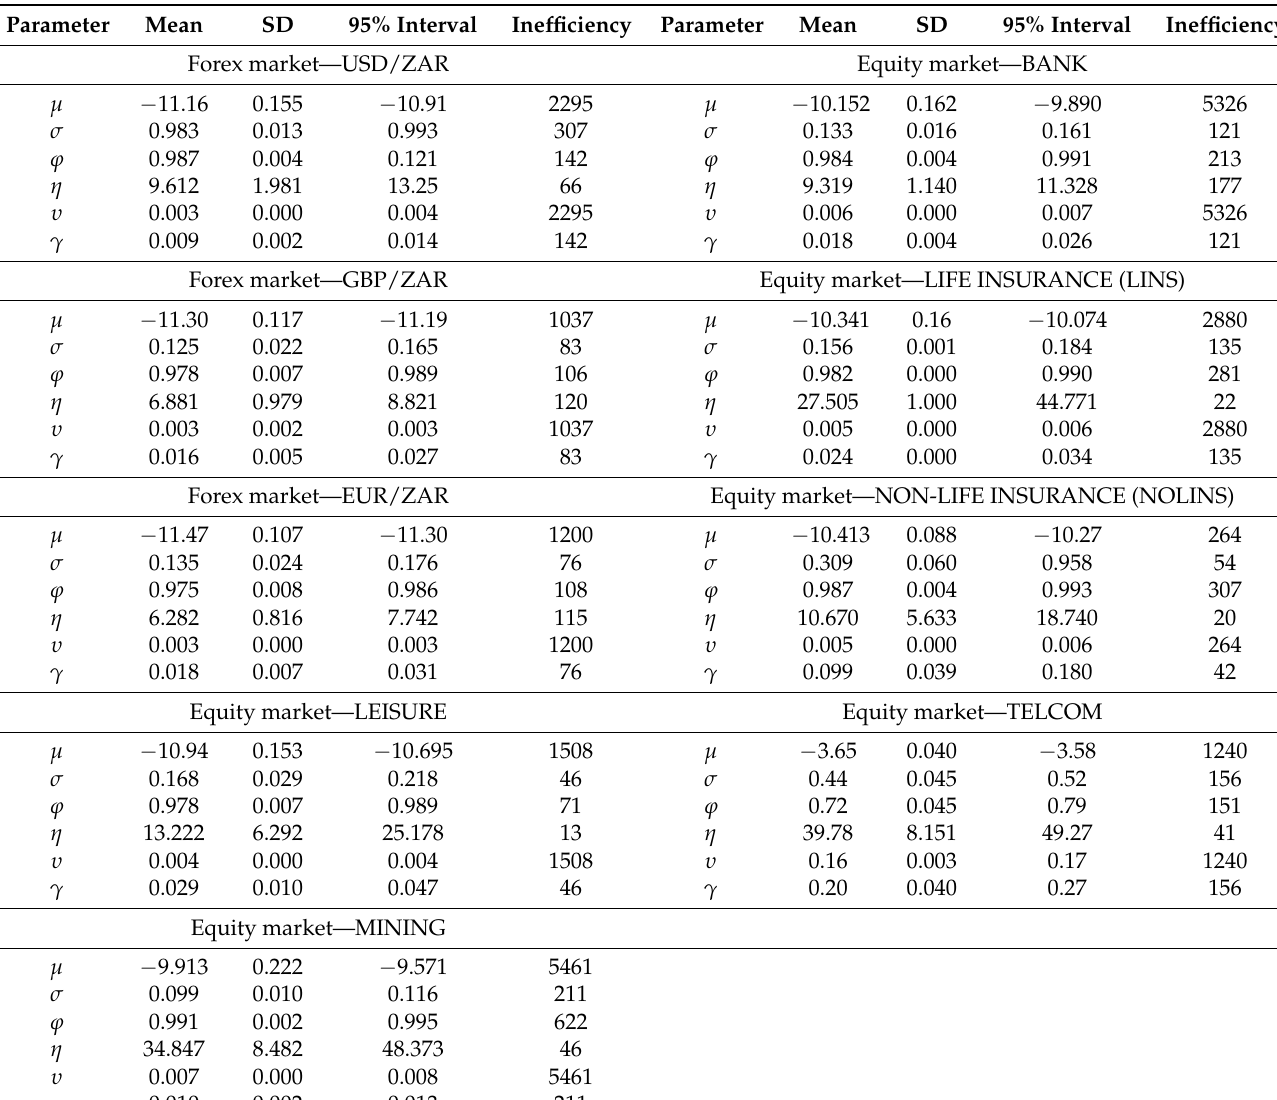
Table 2. Parameter estimates for marginal models using SV model with heavy tail innovations and AR(1)